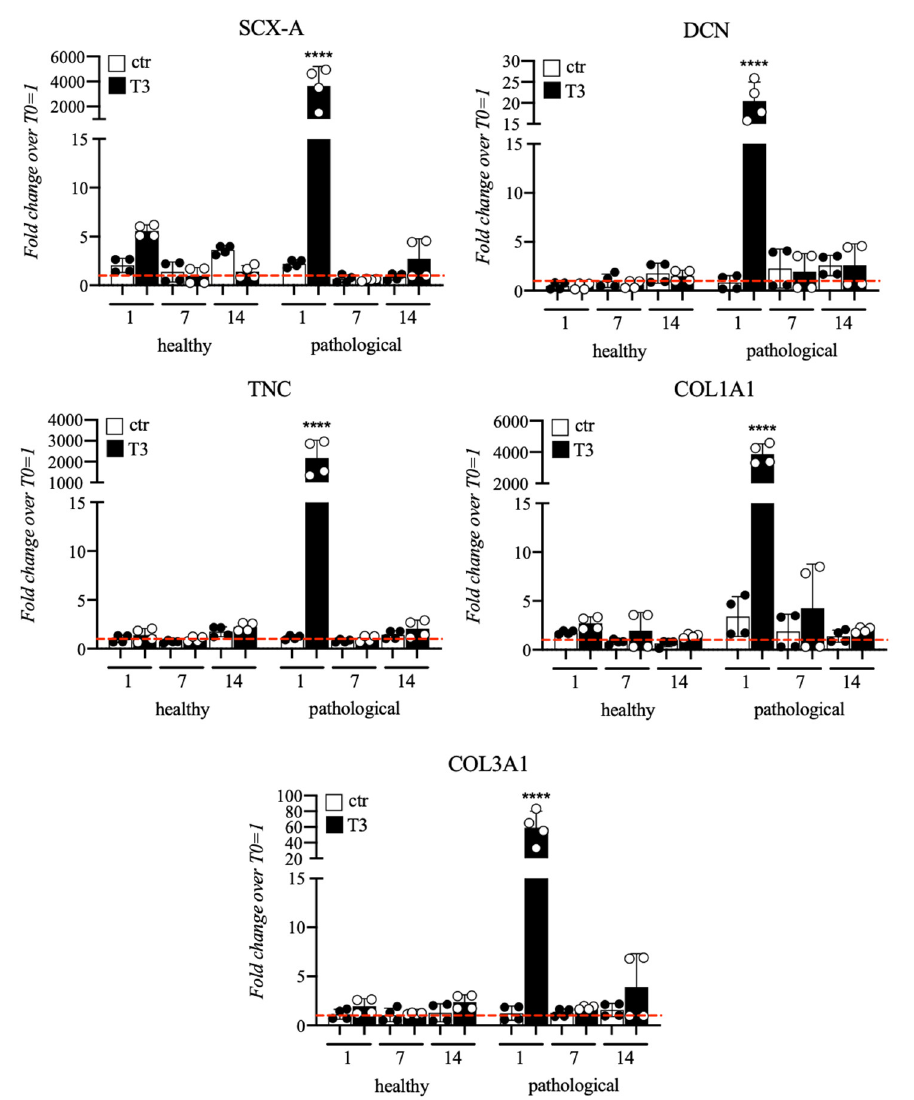
Figure 5. Gene expression profile for tenogenic markers of tendon stem/progenitor cells (TSPCs) cultured in a medium supplemented with T3 (10 −6 M) up to 14 days. Healthy cells showed a rather constant mRNA expression of different tenogenic markers, whereas cells extracted from pathological tendons exhibited larger overexpression of SCX-A, DCN, TNC, COL1A1, and COL3A1 at Day 1. Results are shown as mean ± SD. **** p < 0.0001 (N = 4).